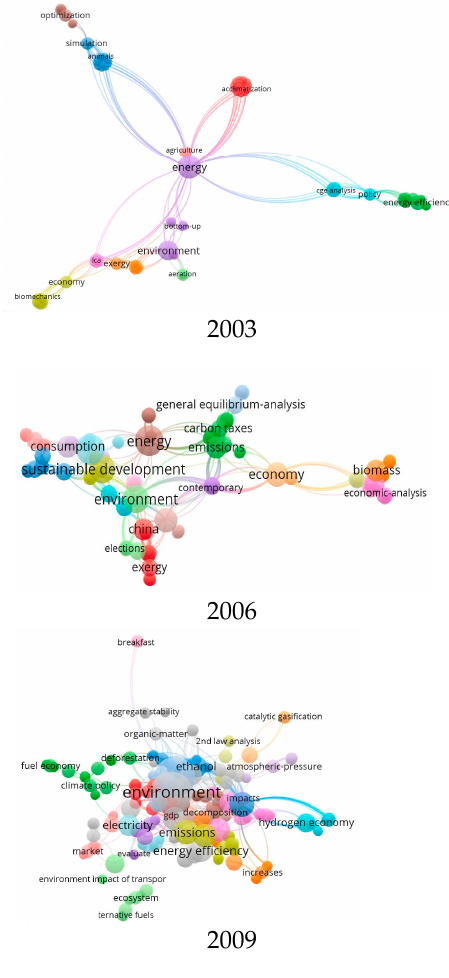
Figure 5. Evolution of keywords from 2001 to 2009.